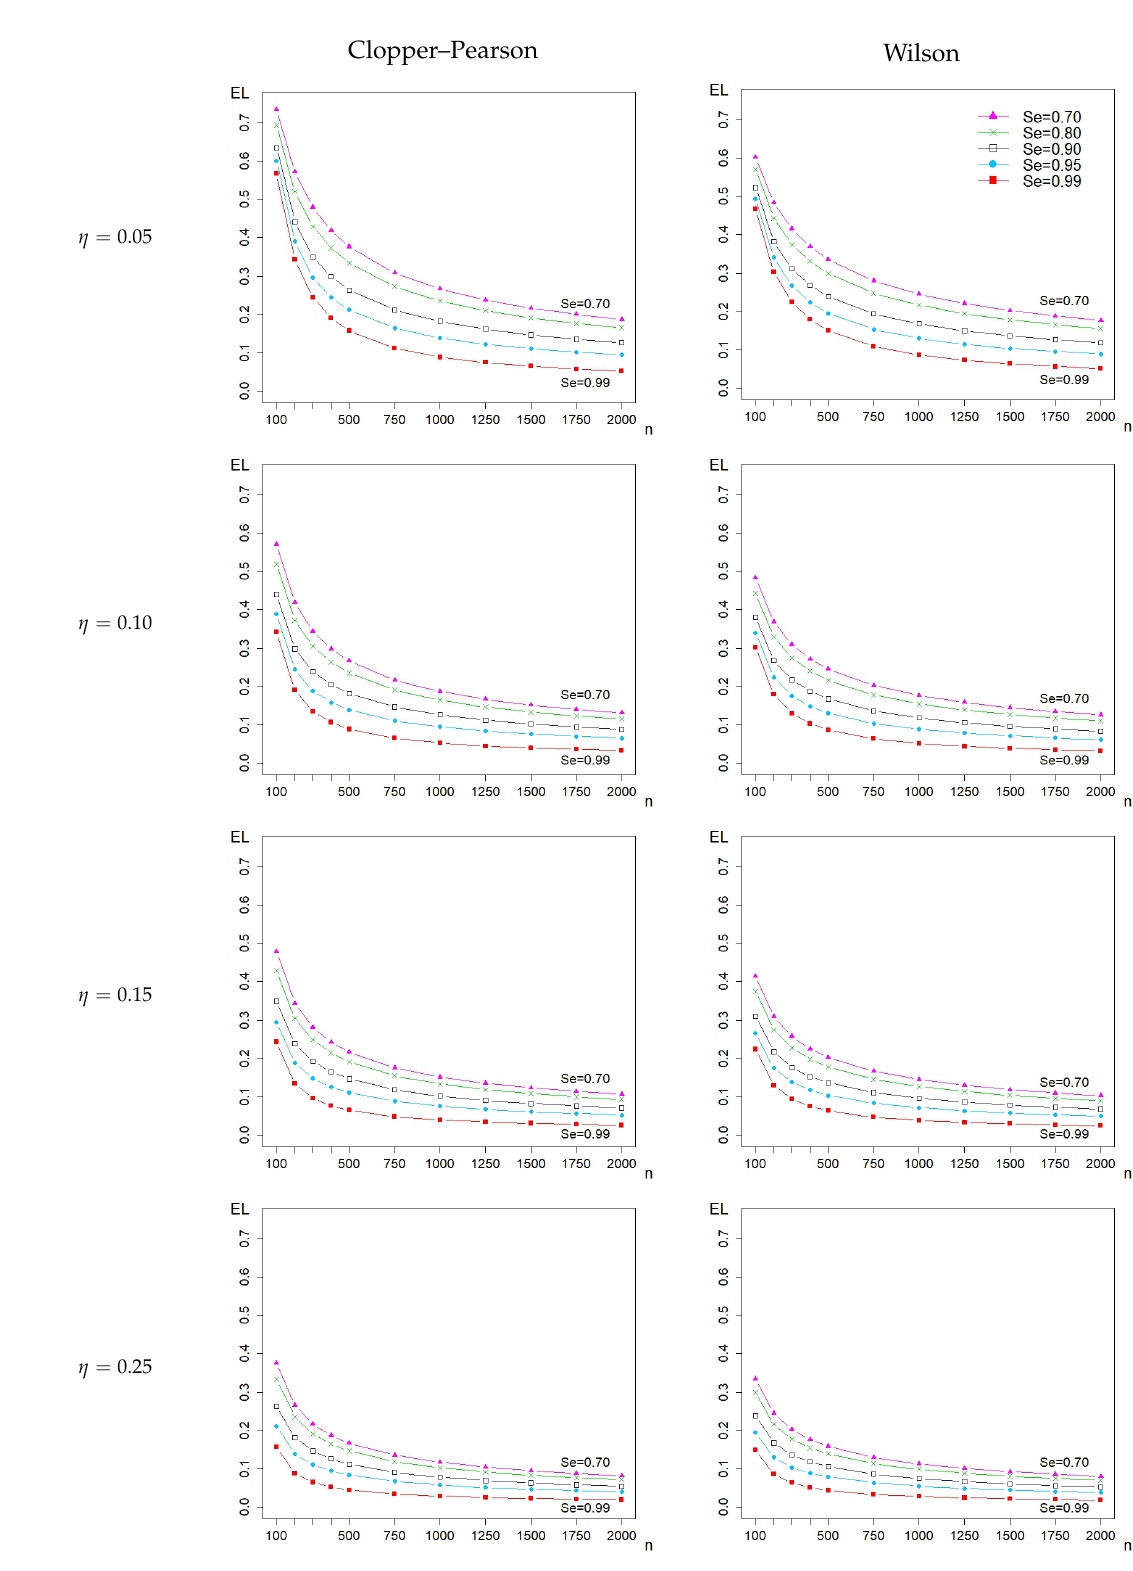
Figure 4. Expected length of sensitivity intervals varying with the sample size ( n ), for η = 0.05; 0.10; 0.15; 0.25, and Se = 0.70; 0.80; 0.90; 0.95; 0.99, using Clopper–Pearson and Wilson methods with 95% nominal confidence